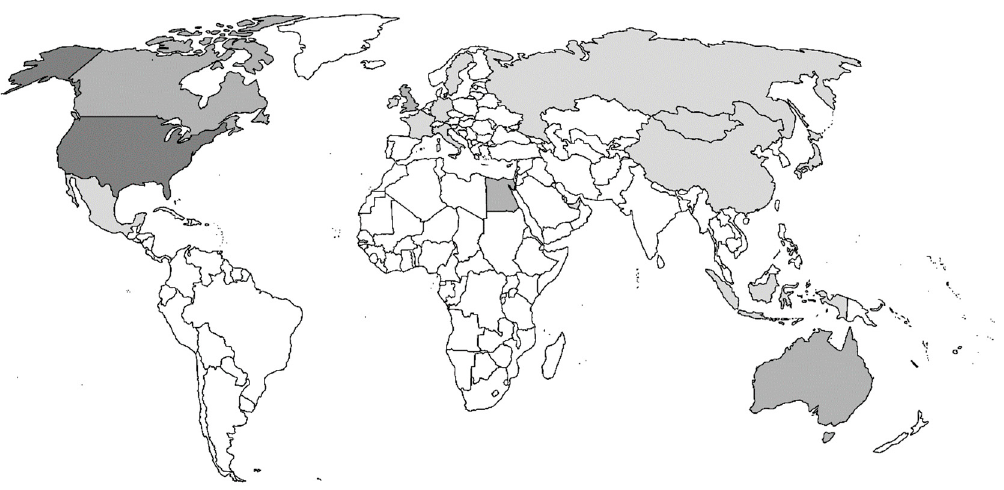
Figure 3. World map of website visitor country locations.